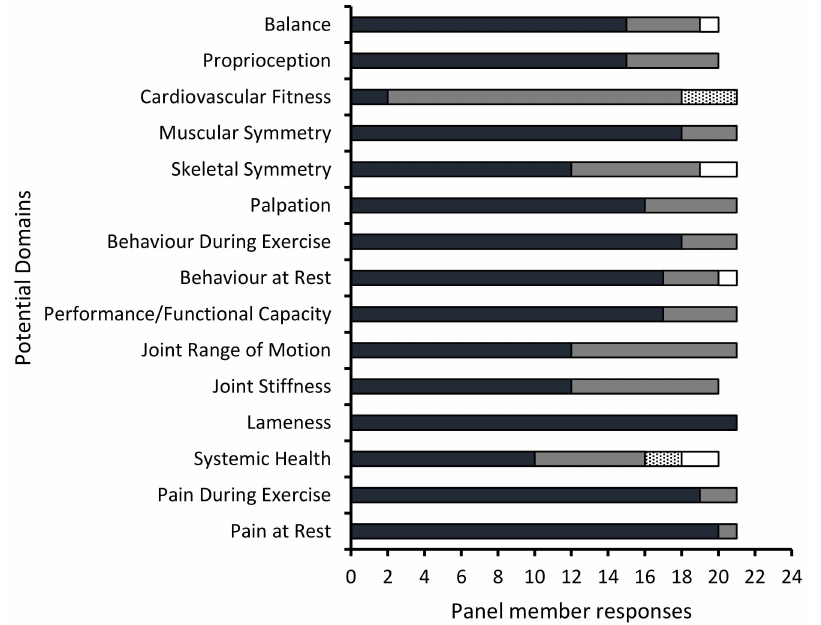
Figure 1. Expert opinion on domains to be included in an equine musculoskeletal outcome